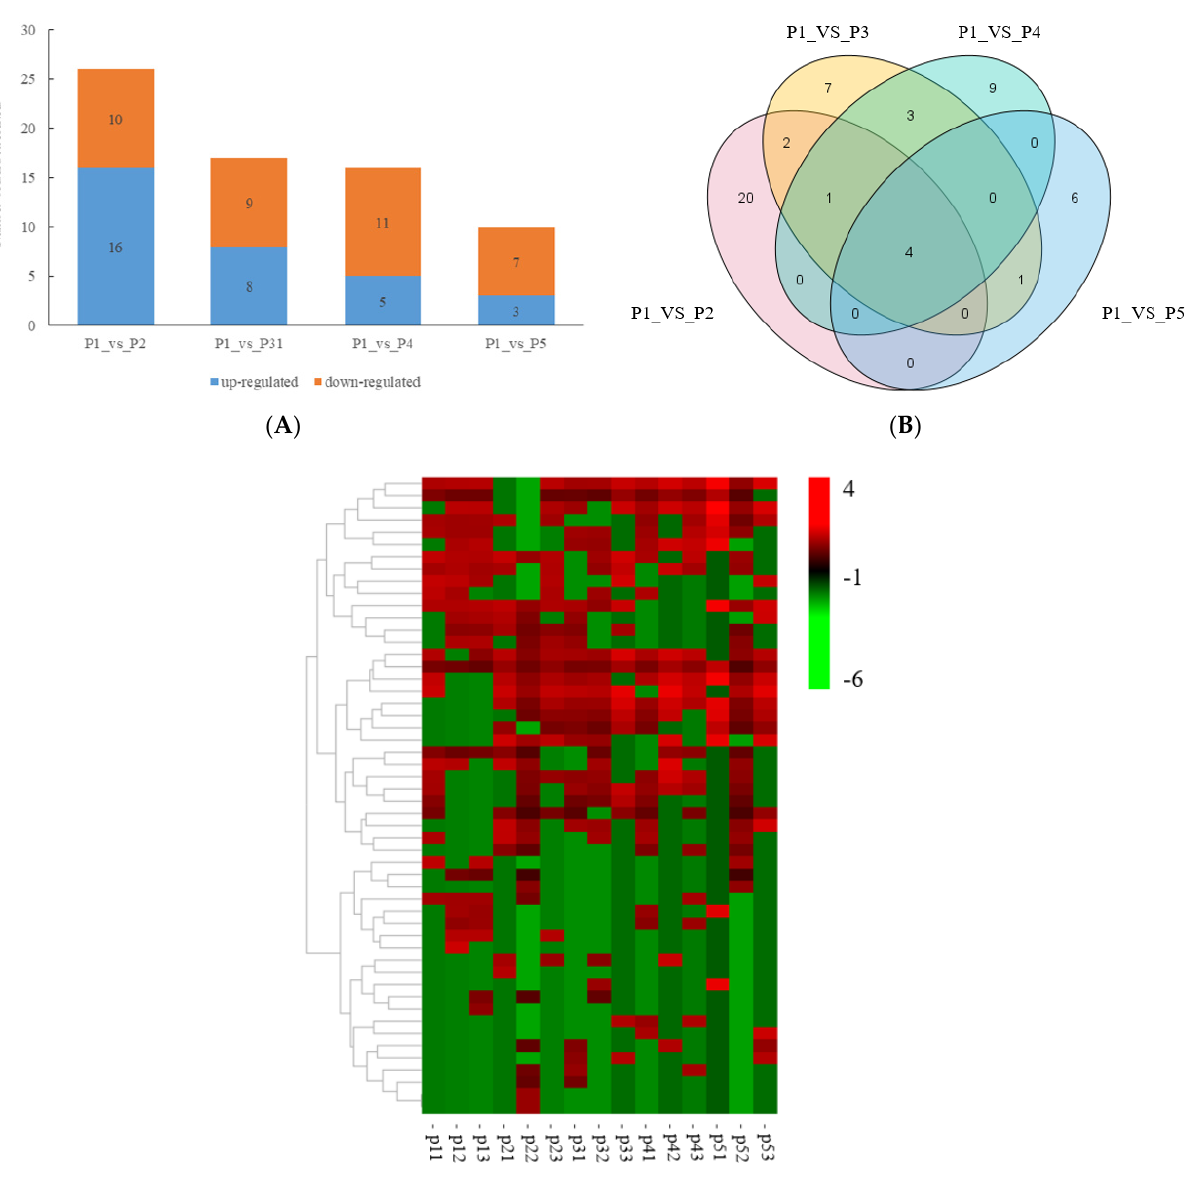
Figure 2. Differential expression analysis of circRNAs in response to drought stress treatment. ( A ) Specific distribution of DEcircRNAs in the four comparison groups. ( B ) Venn diagram of circRNAs distribution in different comparisons. ( C ) Heatmap of expression of all DEcircRNAs in all samples.